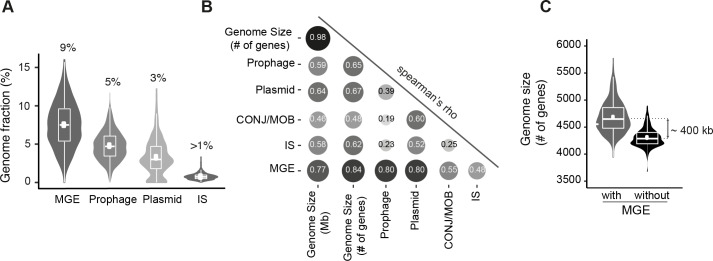
Frequency of mobile genetic elements (MGEs).A. Percentage of genes associated with MGEs per genome (sum in first graph). B. Spearman’s rank correlation matrix between the number of genes related to MGE and the genome size (in Mb and number of genes). The shades of the grayscale and the size of the circle are proportional to the correlation coefficients. All values are significantly positive (P<10−4). C. Differences in genome size when MGE genes are included or removed.